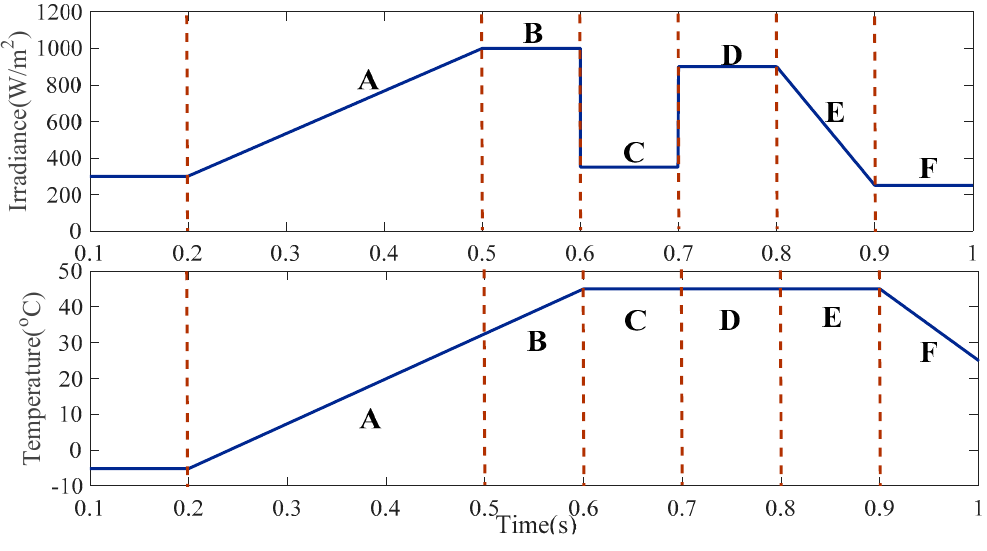
Figure 10. Temperature and irradiance variations in case 1.